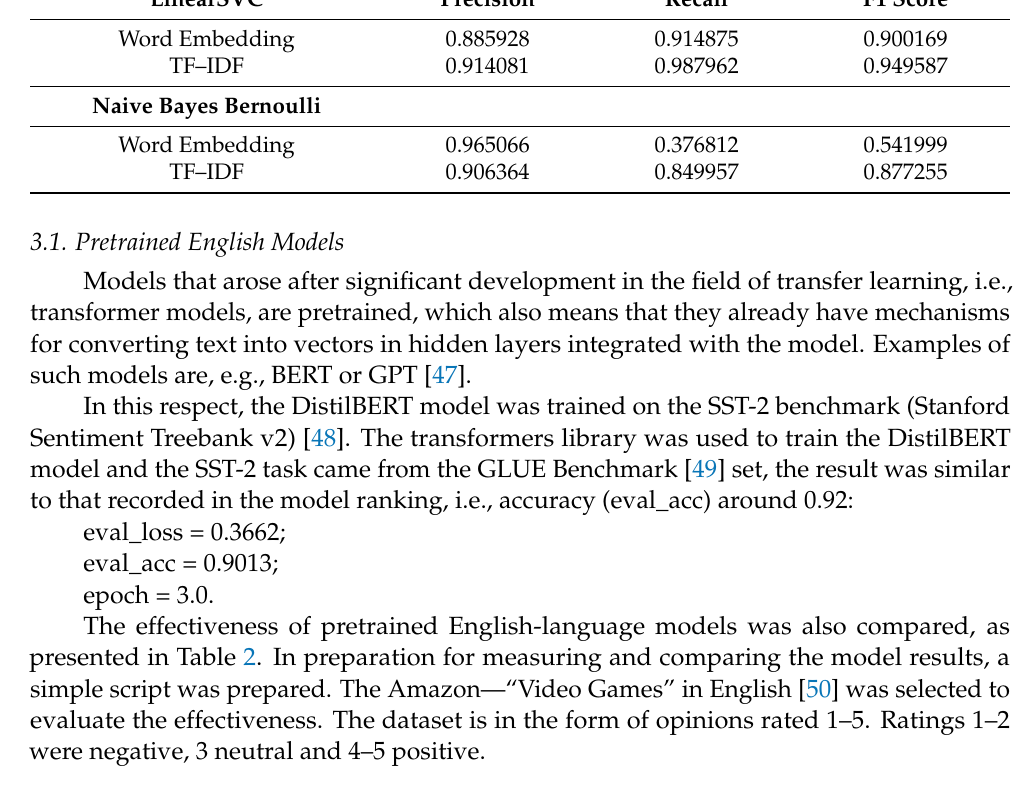
Table 2. Comparison of the effectiveness of the